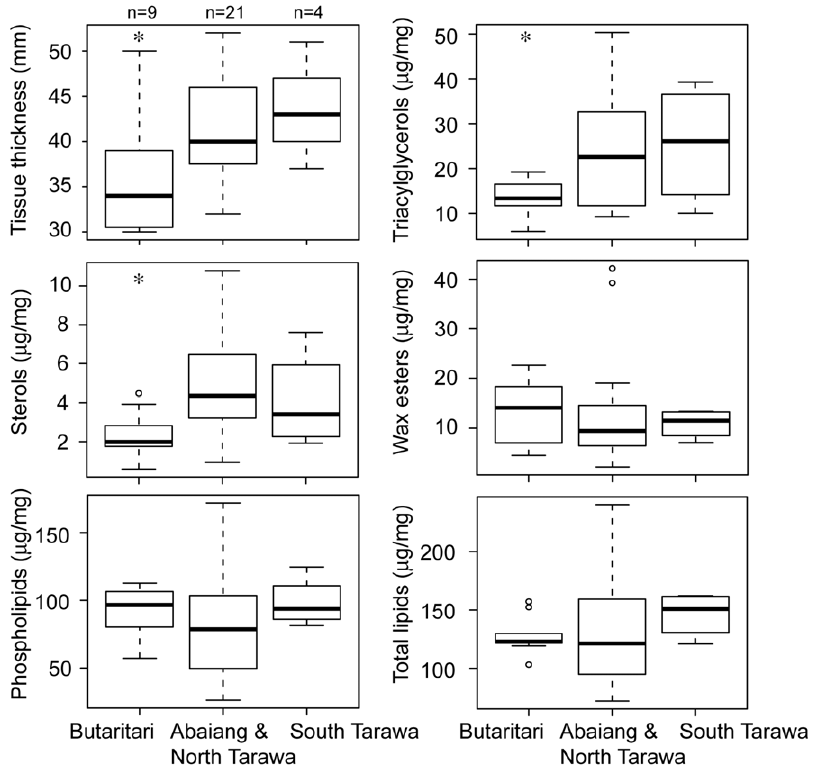
Figure 5. Boxplots of tissue thickness and lipid class concentrations for each island. Lipid concentrations are reported as m g lipid per mg total tissue. Asterisks indicate significant differences between Butaritari and other islands.